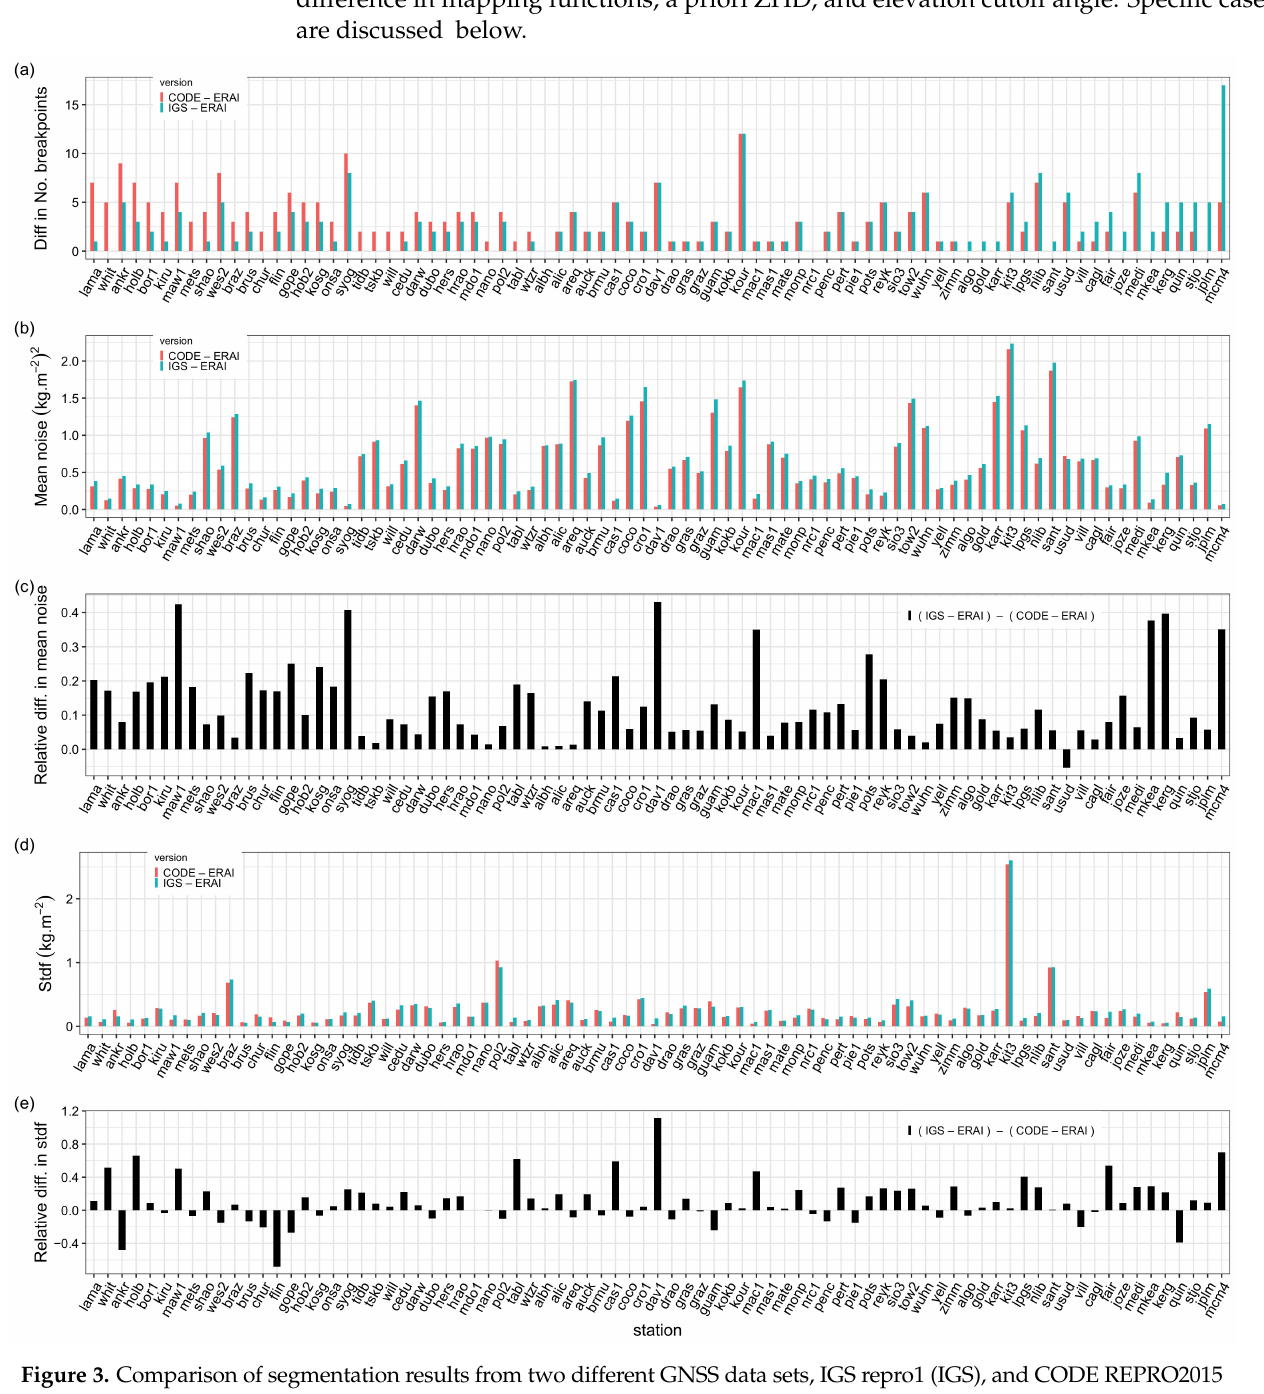
Figure 3. Comparison of segmentation results from two different GNSS data sets, IGS repro1 (IGS), and CODE REPRO2015 (CODE), at 81 common stations: ( a ) number of detected change-points, ( b ) mean of the monthly variance, ( c ) relative difference in the mean of monthly variance (IGS − CODE), ( d ) standard deviation of the functional modeling the periodic bias (stdf), ( e ) relative difference in the standard deviation of the functional (IGS − CODE). All the parameters are estimated from time-matched series for the period 1995–2010. The relative differences are computed relative to the mean (IGS +